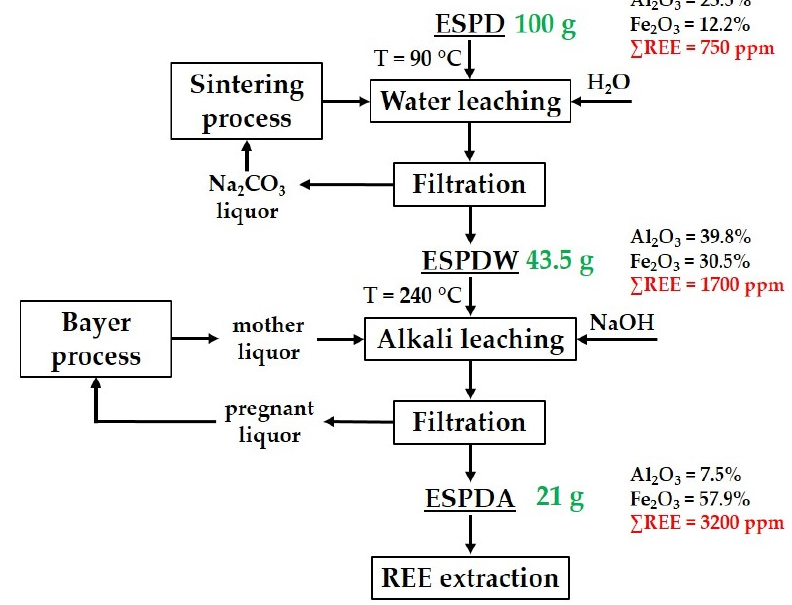
Figure 10. A flowsheet of rare-earth elements (REE) concentration from electrostatic precipitator dust by water/alkali leaching.